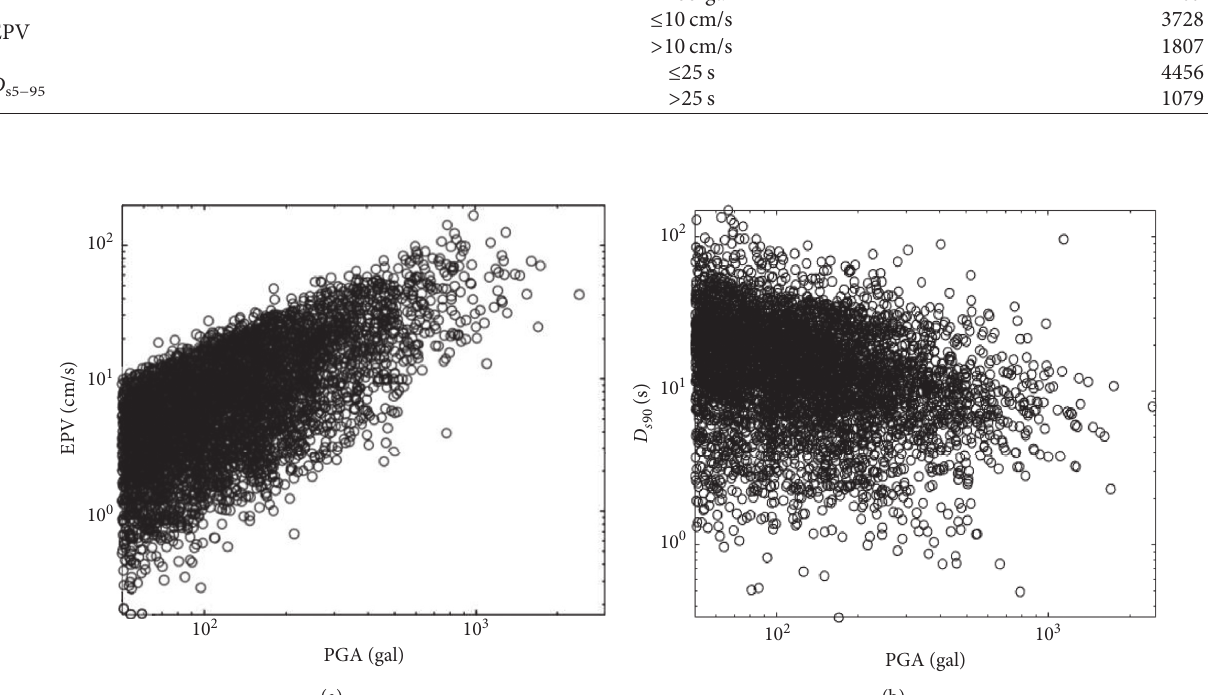
Figure 11: (a) PGA-EPV distribution and (b) PGA- D